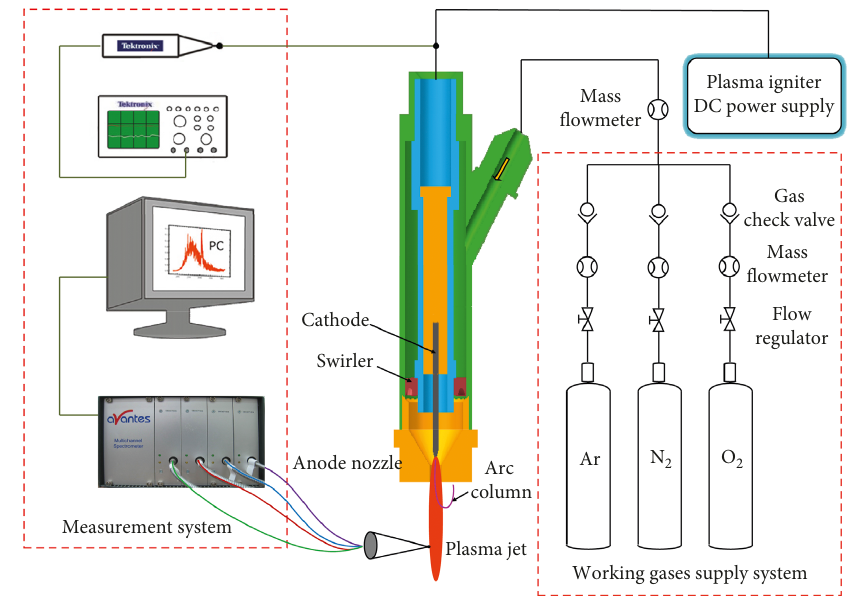
Figure 1: Schematic diagram of the plasma igniter experimental system.